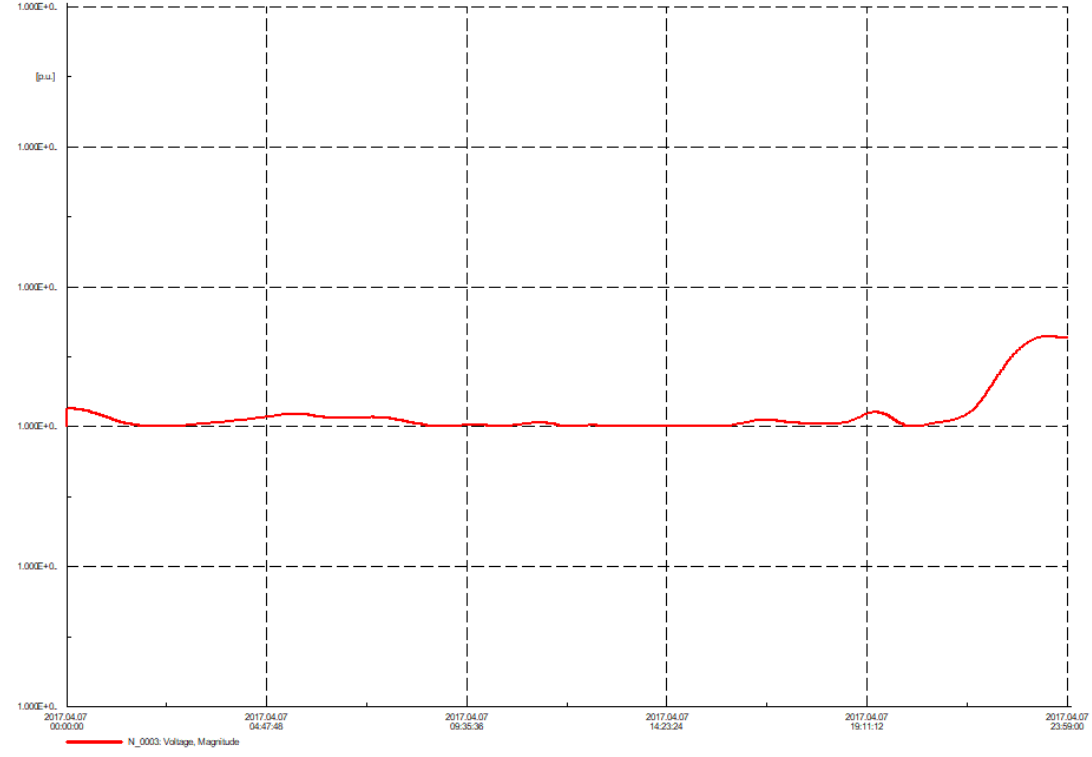
Figure 6. Voltage at bus 3 after addition of STATCOM.